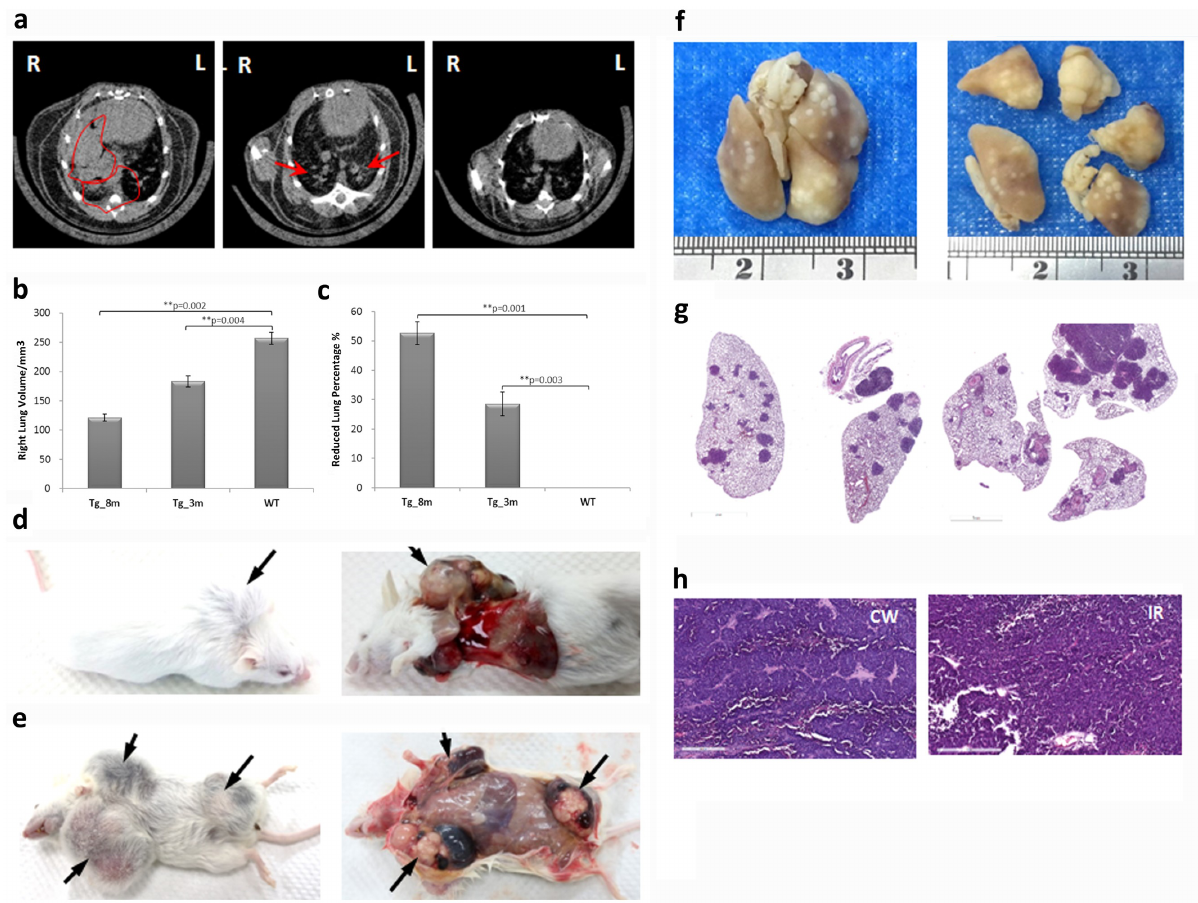
Fig 3. Tumor growths and metastasisof transgenic mice. (a) Normal lung (wild-type; WT) and lungtumors at 3 (Tg-3m) and 8 months (Tg-8m) were evaluatedusing micro-CT. Arrows and circles indicatewhere solitary tumor noduleswere observed. (b-c) Bar charts represent analyticalresults of the growinglung volume (mm 3 ) and the reducedlung volume percentage compared to wild-type mouse (%). Statistical analysisbetweeneach stage of lung tumors and wild-typelung (Tg-8m v.s. WT and Tg-3m v.s. WT) was significant( P value < 0.05) in t -test; group statistics of Tg-8m, Tg-3m, and WT lungs were also significant( P value < 0.001) as verified using ANOVA (data not shown). The lung images shown of each age were representative of more than 3 animalsthat been scanned.(d-e) Macroscopicfeatures of tumors in the chest wall and inguinalregion. (f) Macroscopic and histological (g) image of formalin-fixed lung tumor multiplicity(100x magnification, H&E stained). (h) Histologicalexamination of metastatic tumors in the chest wall (CW) and inguinalregion(IR) (H&E stained). Histologyof the metastatic nodulesrevealedtypical ADCs features of roundedaggregatesof tumor cells or acinar pattern with a glandular formation and cribriform arrangements. Scattered tumor cells within myofibroblastic stroma were also noted (400x magnification).